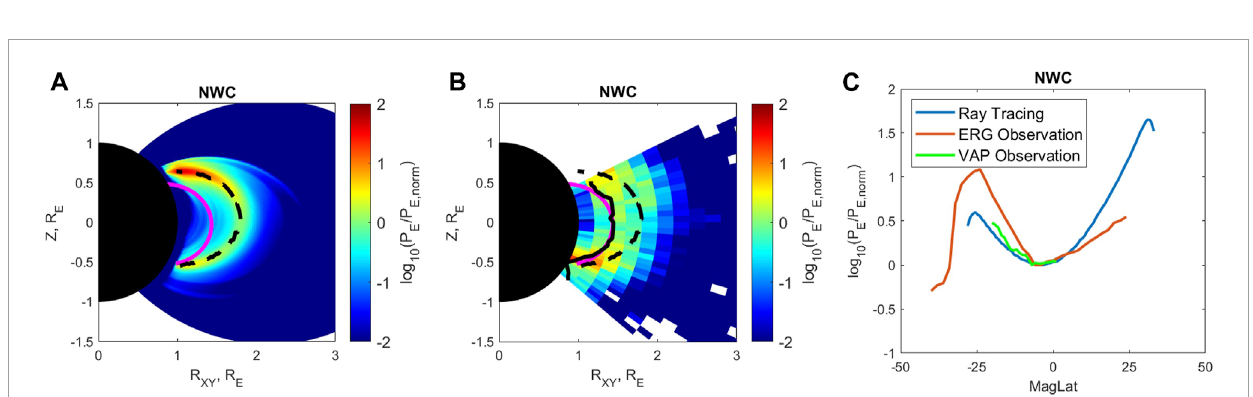
FIGURE 3 The meridional distribution of normalized NWC wave power from ray-tracing simulation (A) and ERG/Arase observation (B) . (C) Is the relative change in the peak NWC wave power over magnetic latitude from the ray-tracing simulation (blue line), ERG/Arase observation (red line) and Van Allen Probes (green line). The black dashed lines in (A, B) represent the trajectories of the wave power peak location ( r 0 ) from the Ray Tracing simulation. The black solid line in (B) is the trajectory of r 0 for the ERG/Arase observation. The magenta solid line is the IGRF magnetic field line starting from the maximum NWC transmitter wave power location observed by